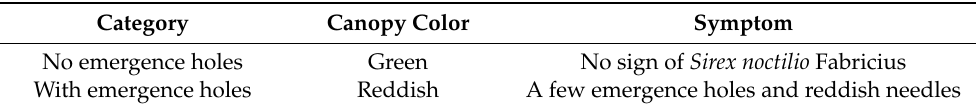
Table 1. Canopy color and symptoms of the first group of Pinus sylvestris var. mongholica Litv. Category Canopy Color Symptom No emergence holes Green No sign of Sirex noctilio Fabricius With emergence holes Reddish A few emergence holes and reddish needles Table 2. Canopy color and symptoms of the second group of Pinus sylvestris var. mongholica Litv. Category Canopy Color Symptom Healthy tree Green No sign of Sirex noctilio Fabricius Tree with a few green leaves Green A few green leaves in the canopy Tree with dead leaves Red Canopy becomes red Leafless tree Gray Canopy with no